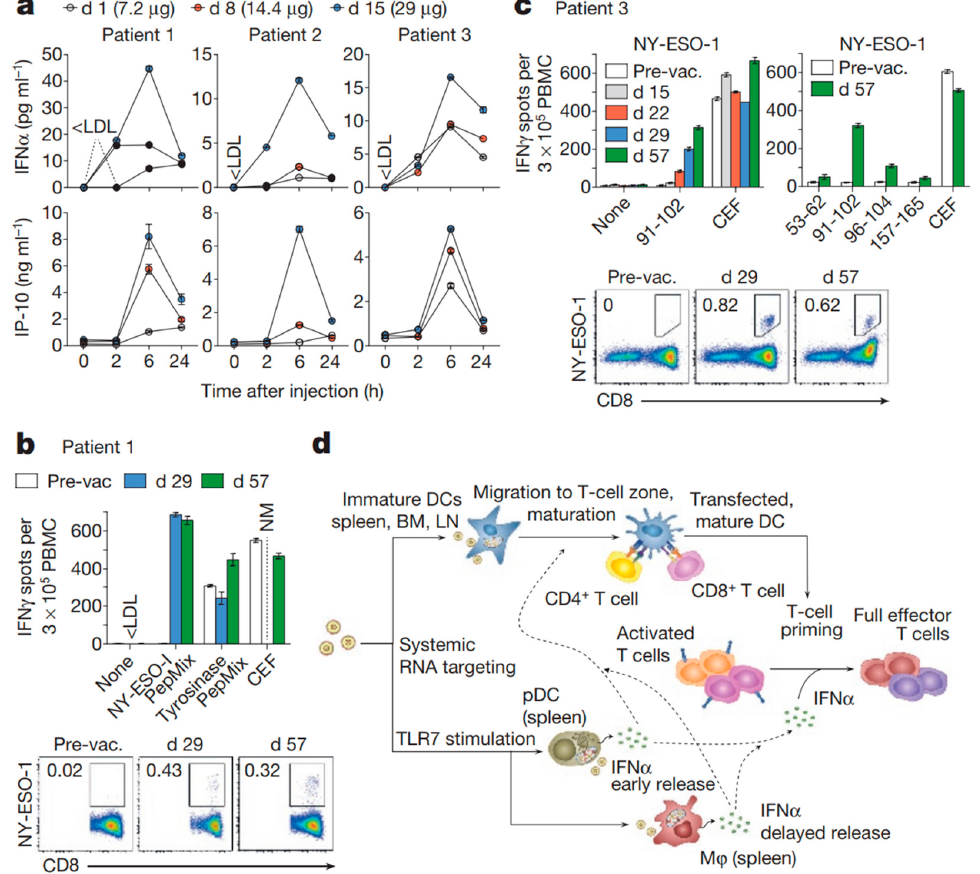
Figure 5. ( a ) Serum cytokines before (0 h) and after injection of intra-patient escalated doses. ( b , c ) T-cell responses against NY-ESO-1 and tyrosinase determined by restimulation with overlapping peptide mixtures or NY-ESO-1 epitopes (indicated with the amino acid position) in IFN γ ELISPOT- and NY-ESO-1-specific MHC class I dextramer staining for patients 1 ( b ) and 3 ( c ). CEF, cytomegalovirus, Epstein–Barr and influenza viruses peptide pool; NM, not measured; PepMix, peptide mixture; pre-vac., pre-vaccination. ( d ) Mechanism of action for RNA-LPX. Error bars, mean ± s.e.m. Reprinted with permission from [152]. Copyright 2016, Springer Nature.